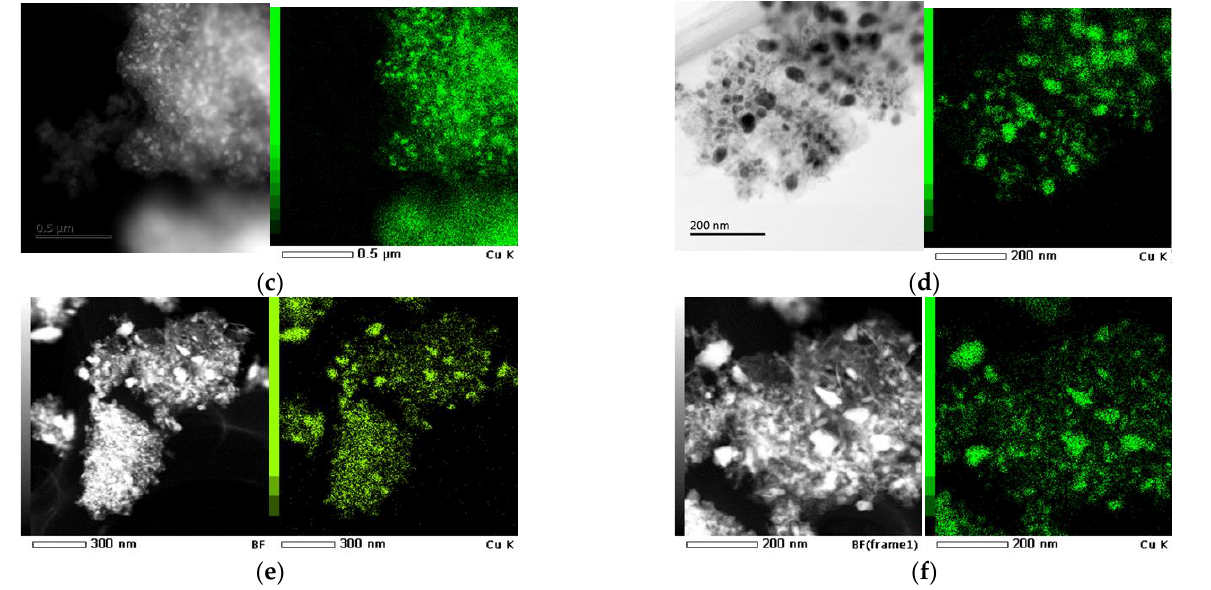
Figure 4. STEM image and EDX maps of Cu of the fresh CMA-L ( a ), spent CMA-L ( b ), fresh CZA-C ( c ), spent CZA-C ( d ), fresh CMA-A ( e ), spent CMA-A ( f ).